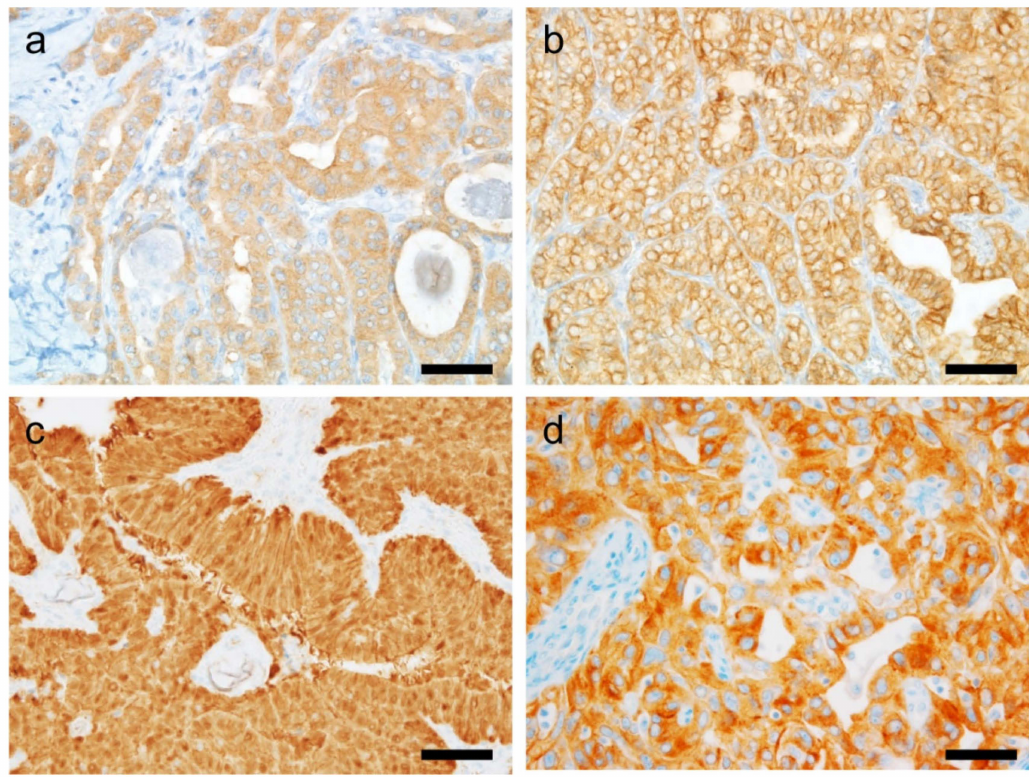
Figure 5. Immunohistochemical detection of mutations in thyroid cancer. ( a ) BRAF VE1 immunos- taining in papillary thyroid carcinoma (PTC) with BRAF V600E mutation. ( b ) Pan-TRK immunos- taining in PTC with RBPMS-NTRK3 fusion. ( c ) Cribriform morular thyroid carcinoma showing nuclear expression of β -catenin. ( d ) ALK immunostaining in PTC with EML4-ALK fusion. × 400 ( a – d ). Scale bar = 50 µ